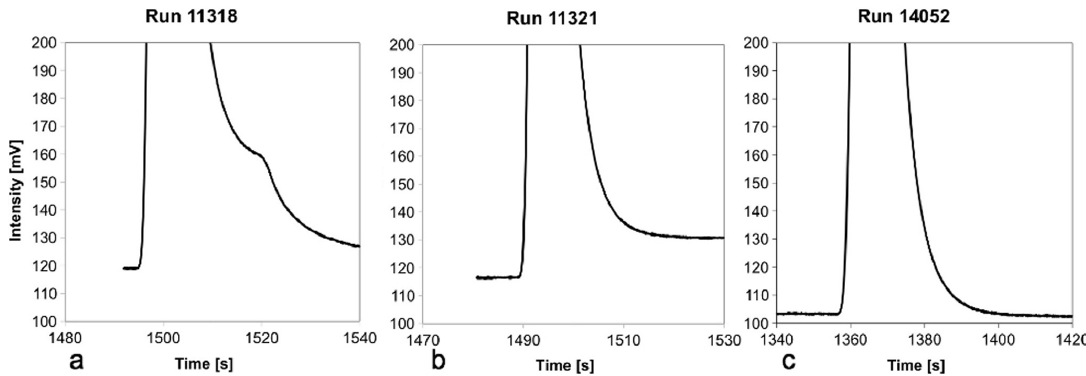
Fig. 4. (a) Before the liquid nitrogen in front of the pyrolysis furnace was introduced, the peak tail showed a “shoulder” (a) or was significant above the background level (b) . The front trap improves the peak shape of the sample, especially at the tail (c) . Trapped components are vented to the open spilt with a high flow rate after the sample detection is